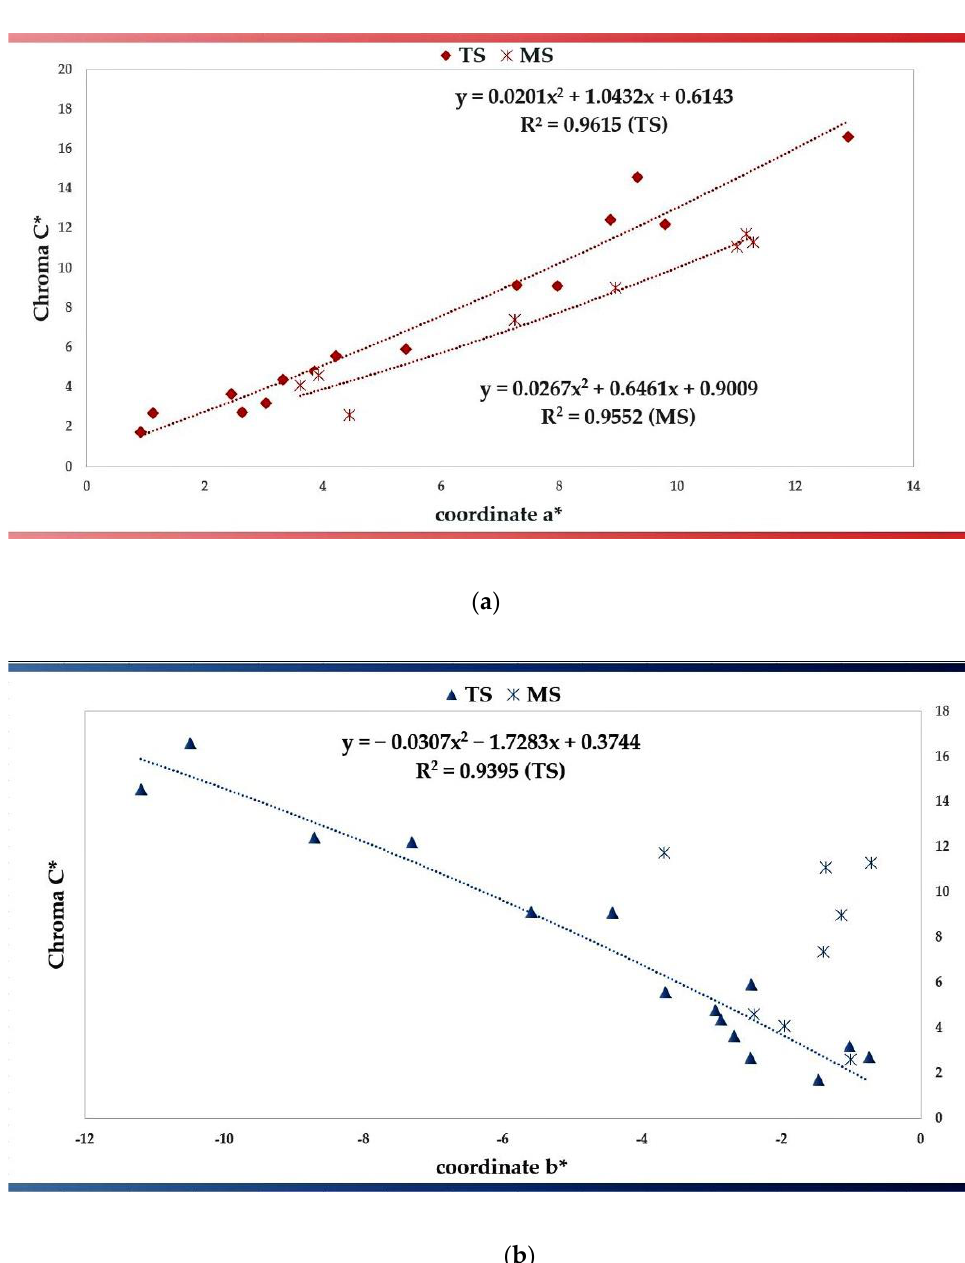
Figure 14. The color analysis of purple-violet spinel. ( a ) A highly positive correlation between the color coordinates a* and its chroma C*. ( b ) A positive correlation between the color coordinate −b* and its chroma C* for TS and a weak correlation between these two parameters for MS.